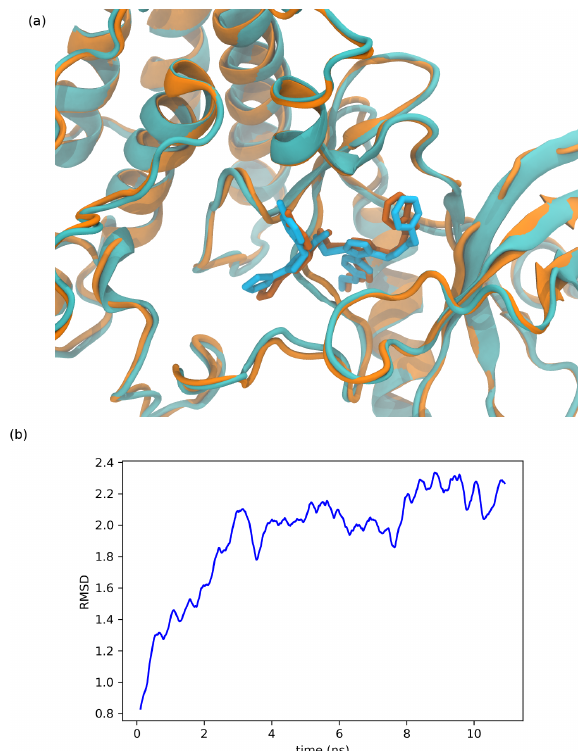
Figure 8. ( a ) Comparison between the initial docking pose (in orange) of F0514-4011 and the final one after the 10-ns MD simulation (in cyan). ( b ) Evolution of F0514-4011 root mean square deviation (RMSD) during 11 ns (1 ns equilibrium and 10 ns production) of MD simulation. Poses were aligned on the initial one and the curve was